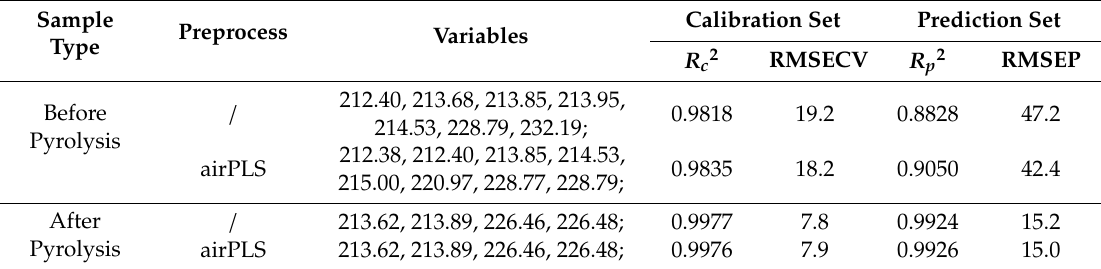
Table 4. The results for LASSO model based on selected